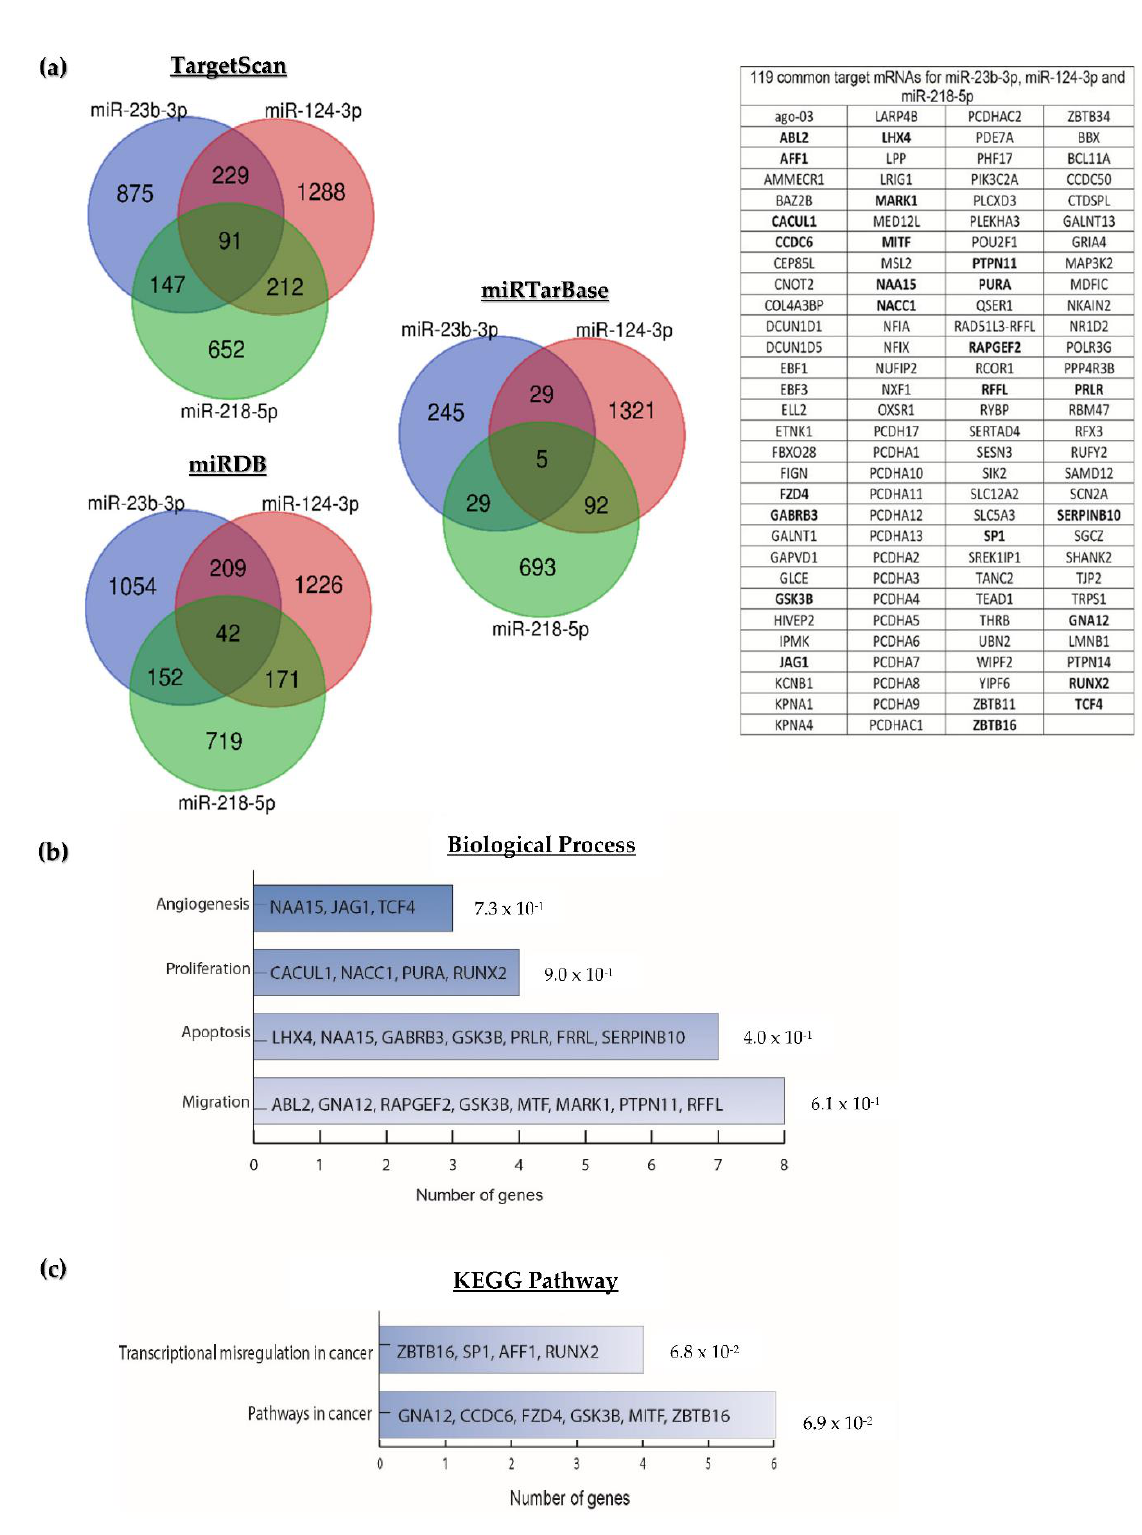
Figure 6. miR-23b-3p, miR-124-3p, and miR-218-5p target mRNAs and enrichment analysis. ( a ) Target transcripts shared between two or three miRNAs; ( b ) analysis of genetic ontology show- ing biological processes; and ( c ) signaling pathways in which the target mRNAs of miR-23b-3p, miR-124-3p, and miR-218-5p